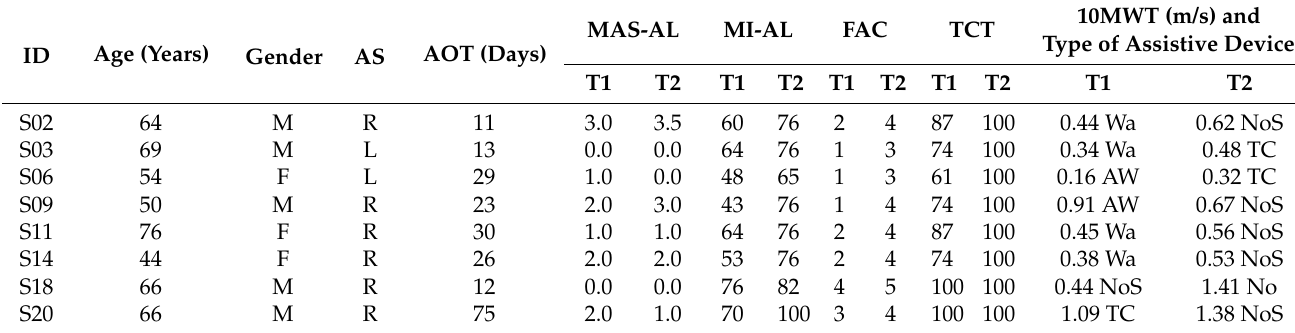
Table 1. Demographic and clinical characteristics of the